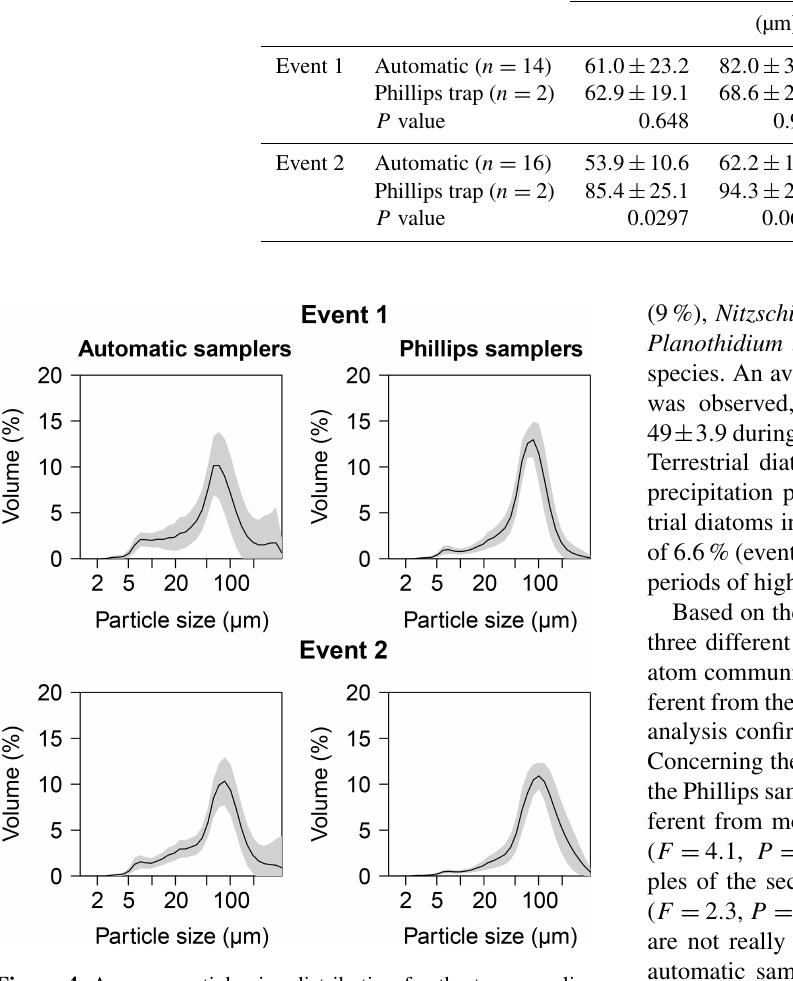
Figure 4. Average particle size distribution for the two sampling methods for the first two events. The grey shaded area indicates the standard